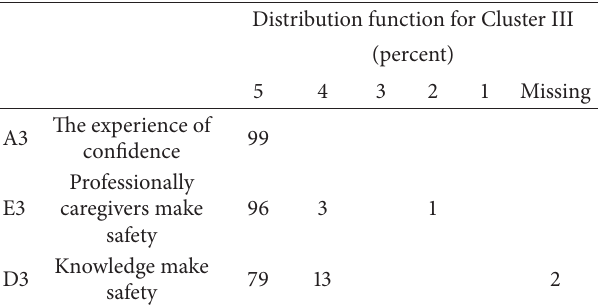
Table 5: Cluster III: